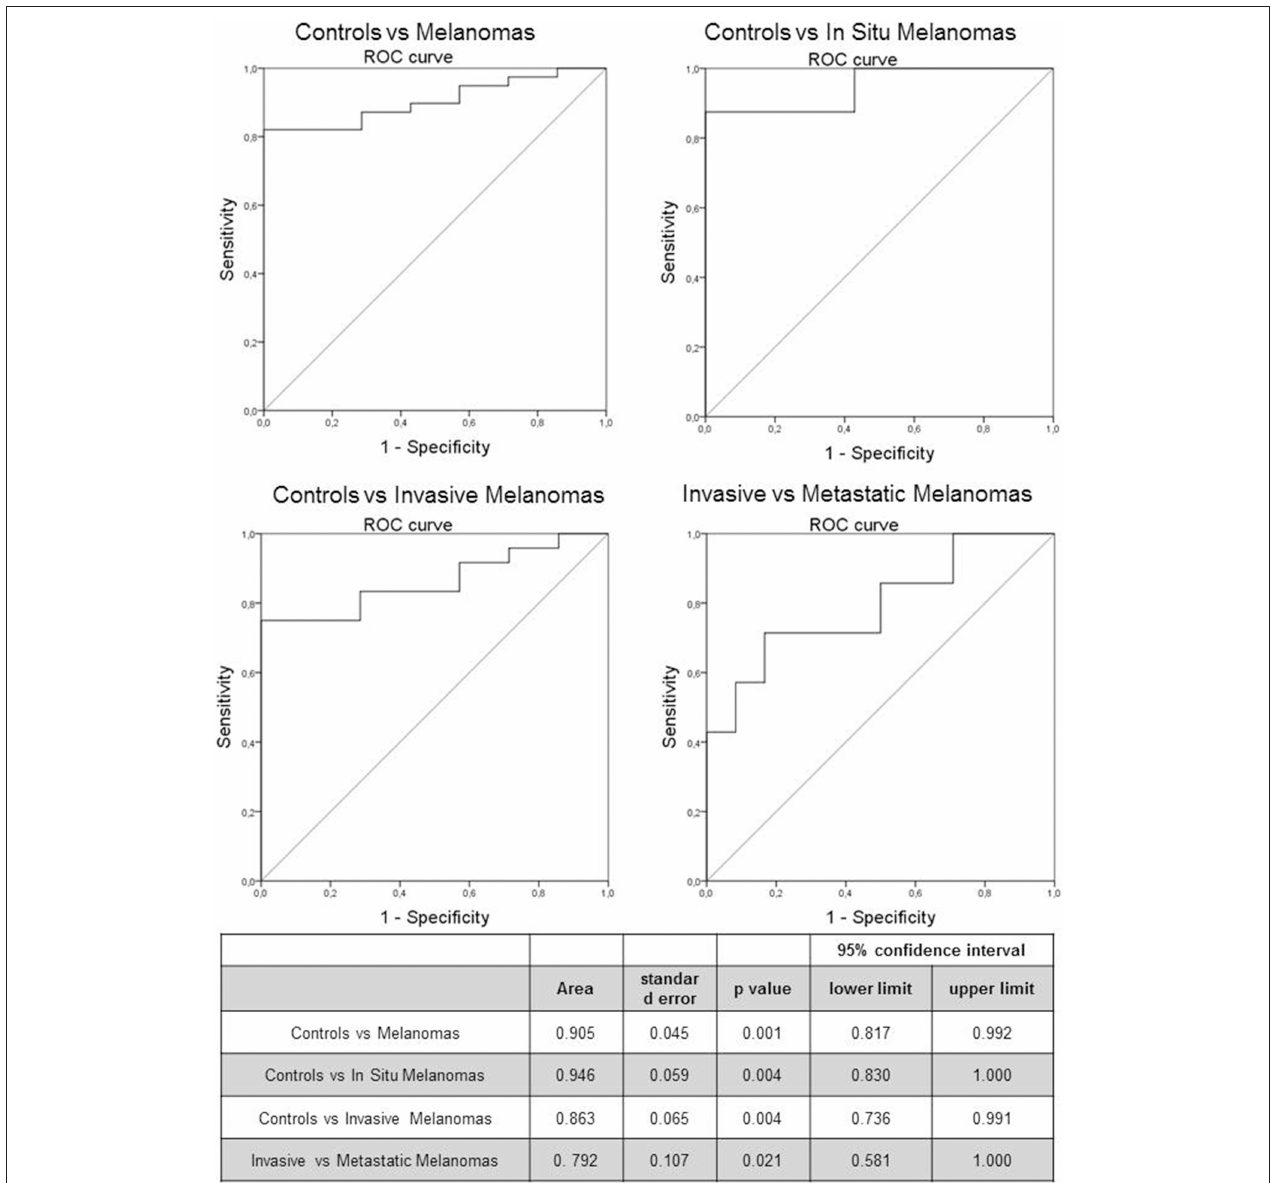
FIGURE 2 | Receiver Operating Characteristic (ROC) curve of RASSF1A methylated cfDNA in melanoma patients and control subjects. The table reports the parameters of the ROC curve.